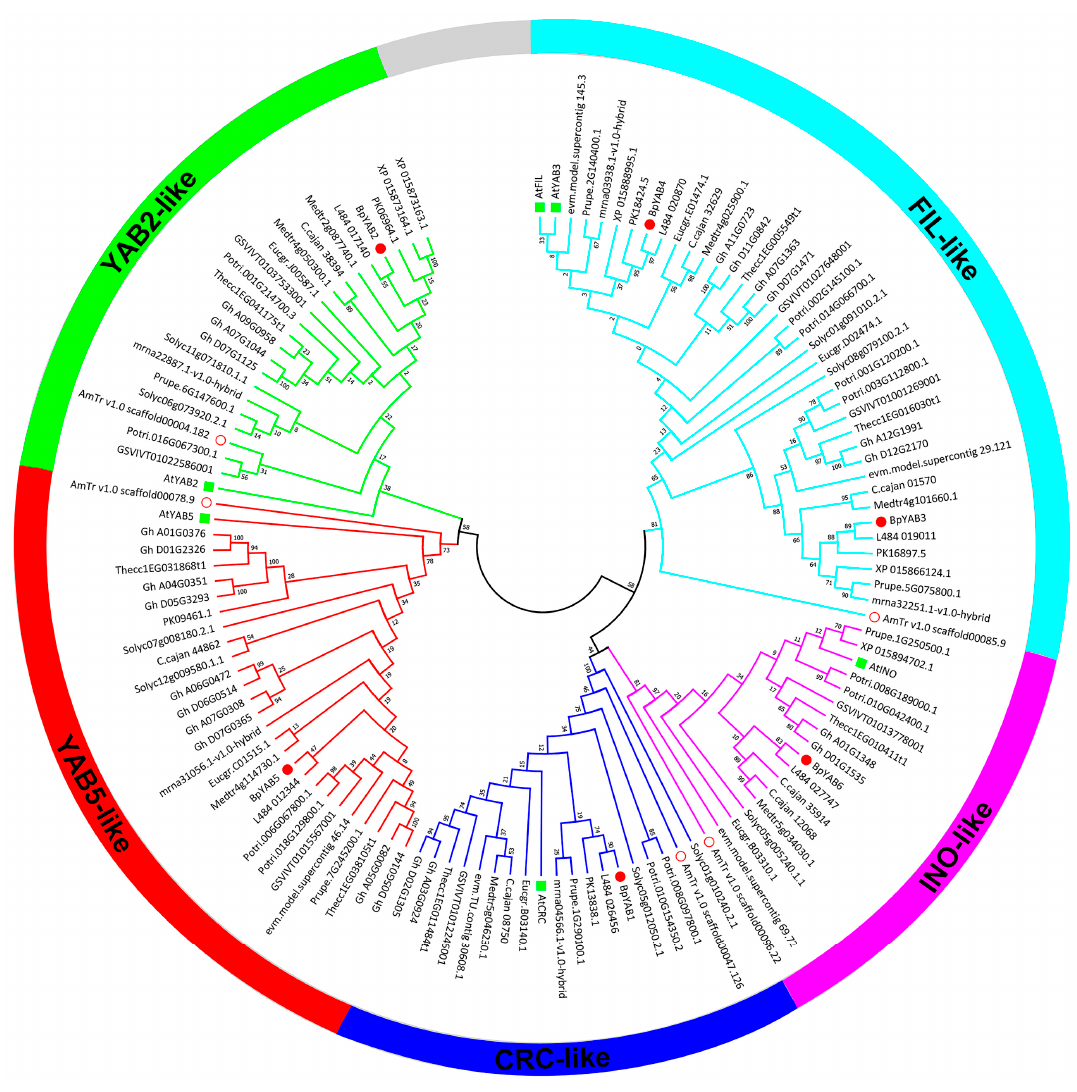
Figure 1. BpYABs clustered into five groups by phylogenetic analysis. The phylogenetic tree of YABBYs is divided into five clades, named FIL -like, CRC -like, INO -like, YAB2 -like and YAB5 -like, containing 127 amino acid sequences from 17 species. The paper mulberry (red filled circle) has two members in the FIL -like group, and other four groups contain only one member. The YABBYs with the green boxes are from A. thaliana and the red circles are from A. trichopoda . All the YABBY proteins were aligned by MUSCLE in MEGA 7.0 and adjusted